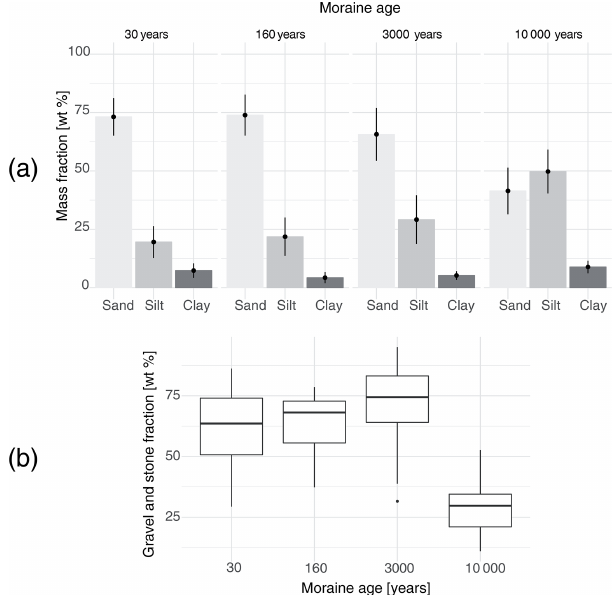
Figure 5. (a) Profile-averaged grain size fractions for the four moraines. Fractions are percentages of the fine earth fraction ( < 2mm). (b) Profile-averaged gravel content ( > 2mm) calculated as the percentage of the entire sample weight. Each average is based on 18